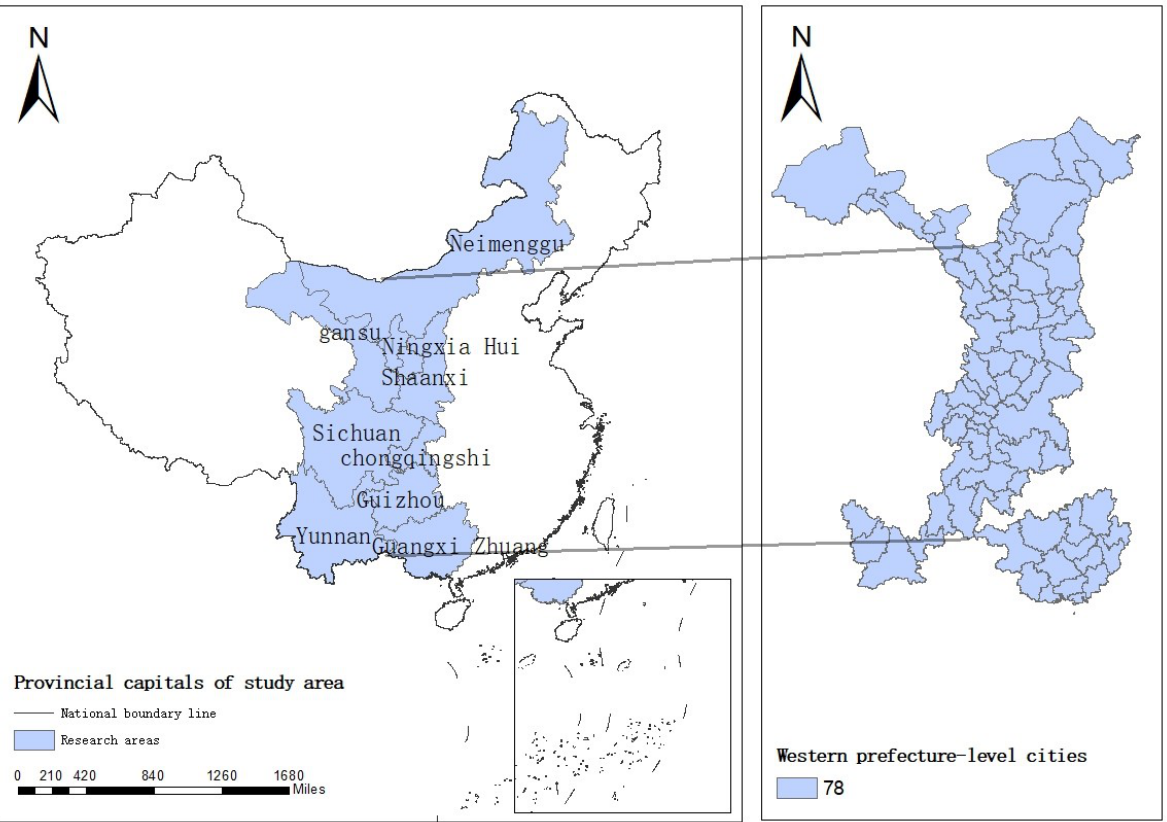
Figure 2. Research